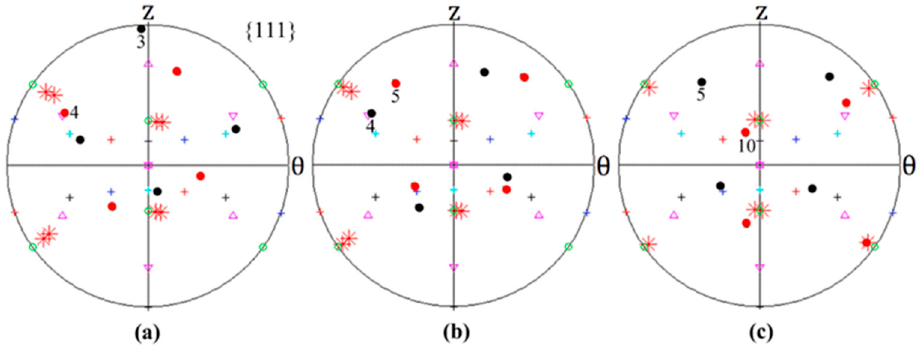
Figure 7. The predicted {111} pole figures of the detected grains along the axial direction. ( a ) Grains 3 and 4, ( b ) Grains 4 and 5 and ( c ) Grains 5 and 10.